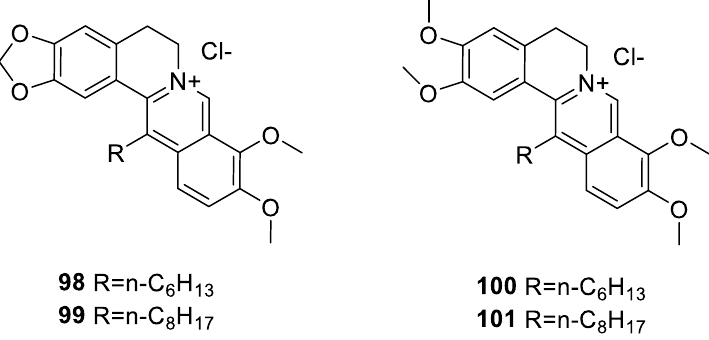
Figure 11. Berberine-13-alkyl derivatives. Figure 11 . Berberine-13-alkyl derivatives. Figure 11 . Berberine-13-alkyl derivatives.